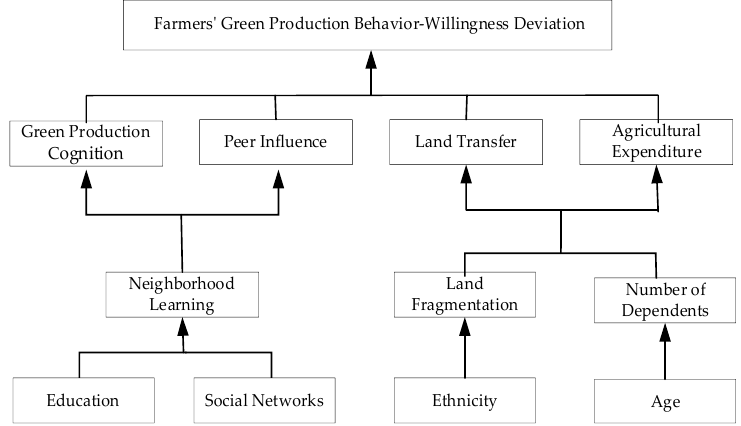
Figure 5. Interpretative structural model of the influencing factors.